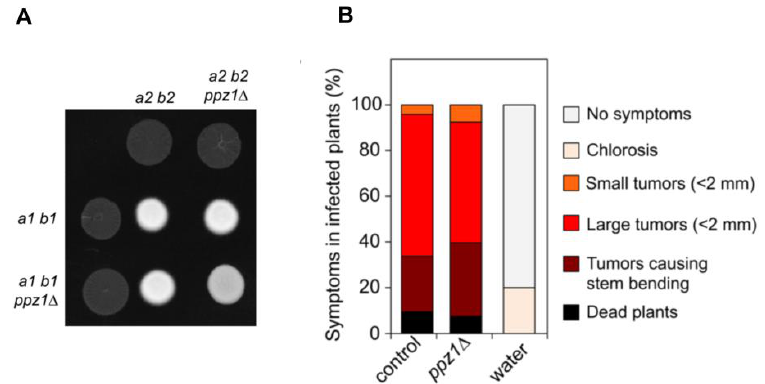
Figure 9. Analysis of virulence of mutants lacking Ppz1 function. ( A ) A ppz1 ∆ mutant is able to mate. Crosses of control as well as ppz1 ∆ mutant strains carrying compatible mating types (a1 b1 and a2 b2) in charcoal-containing agar plates. Positive fuzzy phenotype can be detected as a white-appearance mycelial growth. Note that mutant combinations were slightly a ff ected in the ability to produce fuzzy phenotype. Plates were incubated at 22 ◦ C for two days. ( B ) ppz1 ∆ mutant strains are able to infect plants. Disease symptoms caused by crosses of wild-type and ppz1 ∆ mutant strains. The symptoms were scored 14 days after infection. Two independent experiments were carried out and the average values are expressed as percentage of the total number of infected plants (n: 30 plants in each experiment).